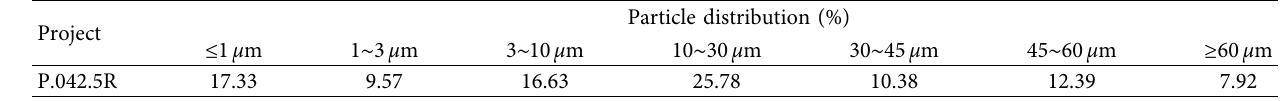
Table 3: Main chemical components of cement.